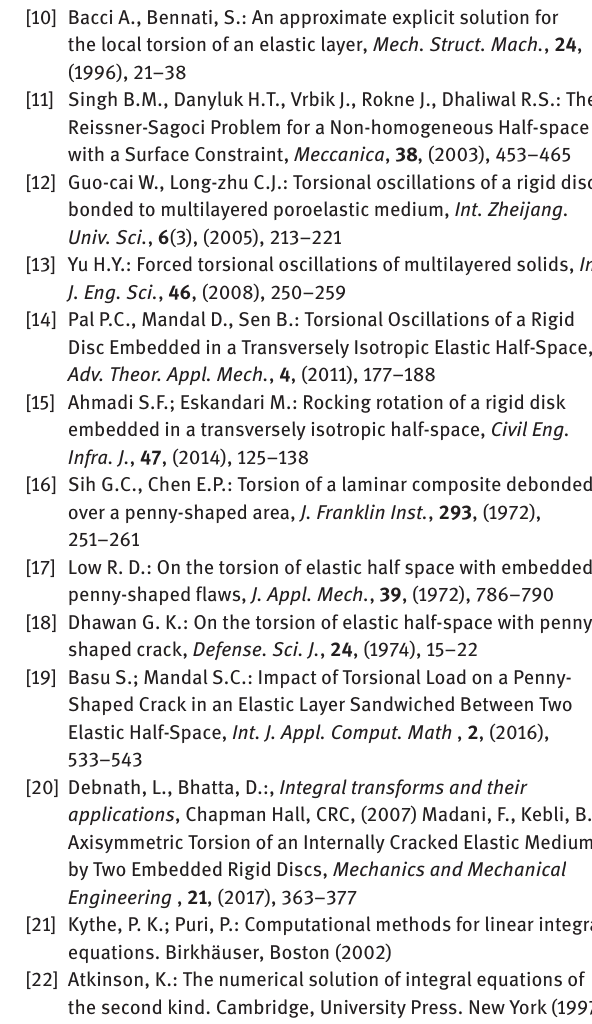
graphically for some dimensionless parameters. The